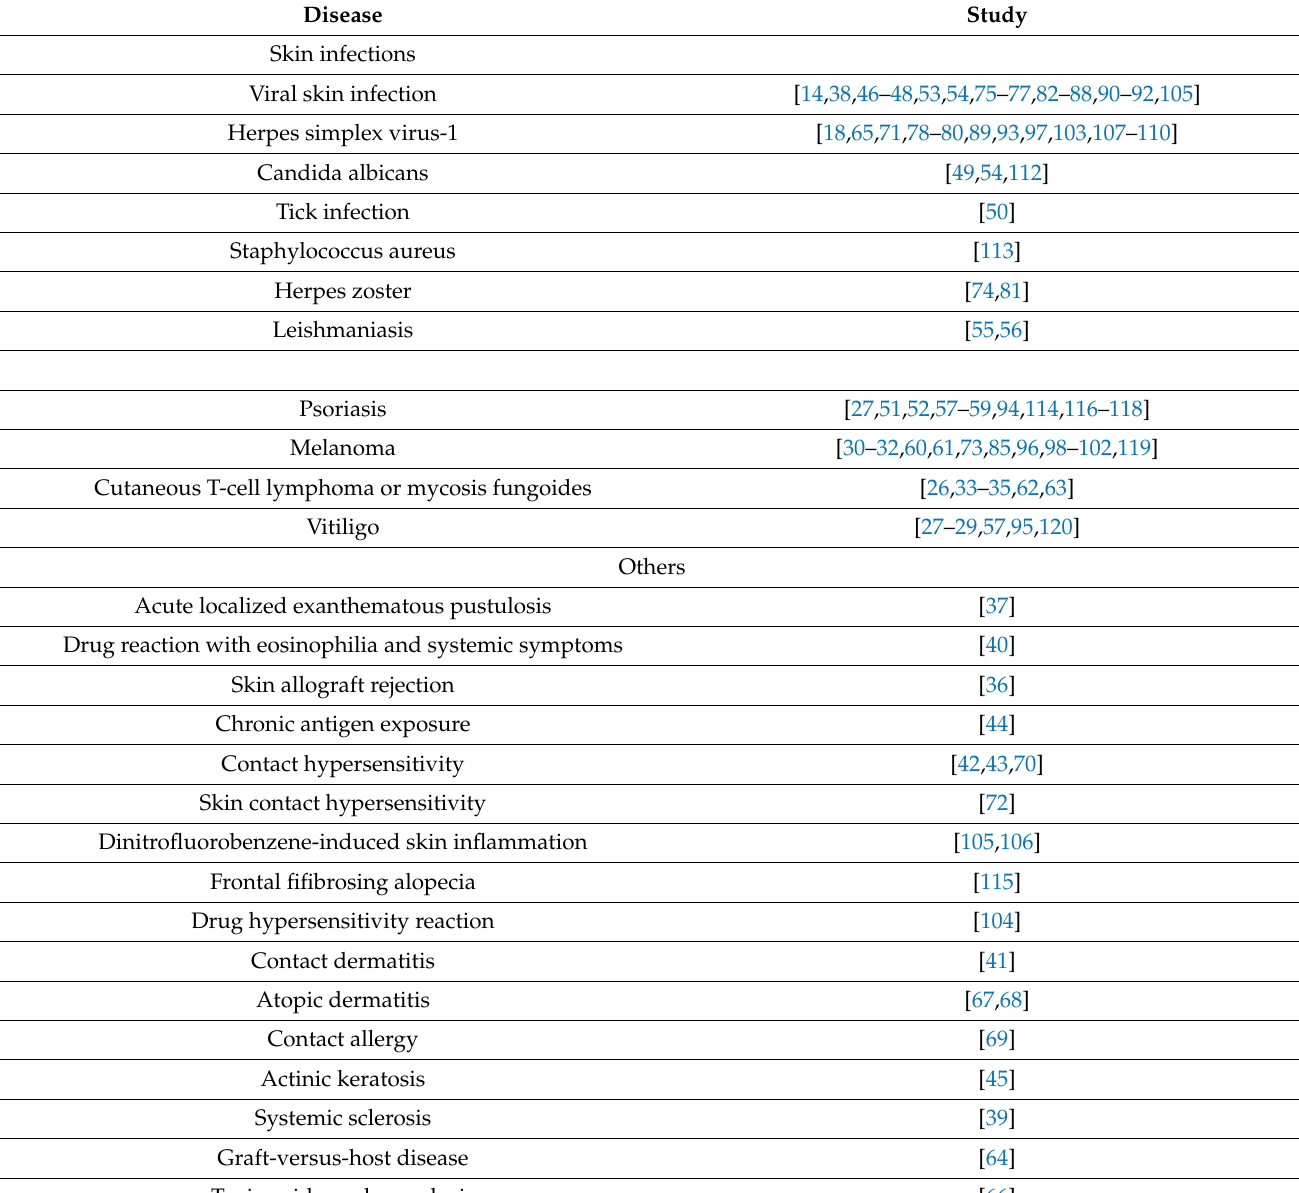
Table 2. List of diseases. Tissue-resident memory T cells were mostly investigated in various infectious skin